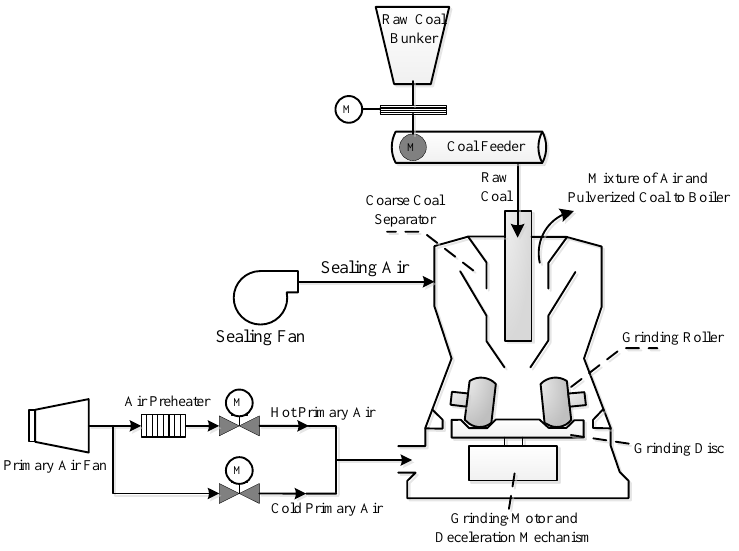
Figure 1. The structure of MPS medium-speed coal mill system.